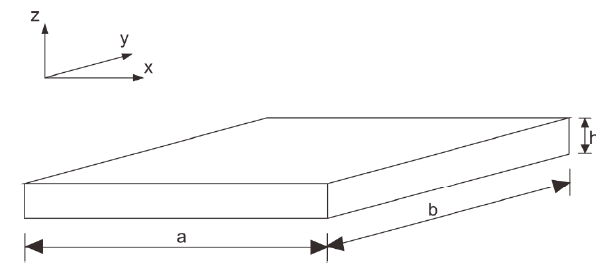
Figure 2: Thin plate sketch geometry